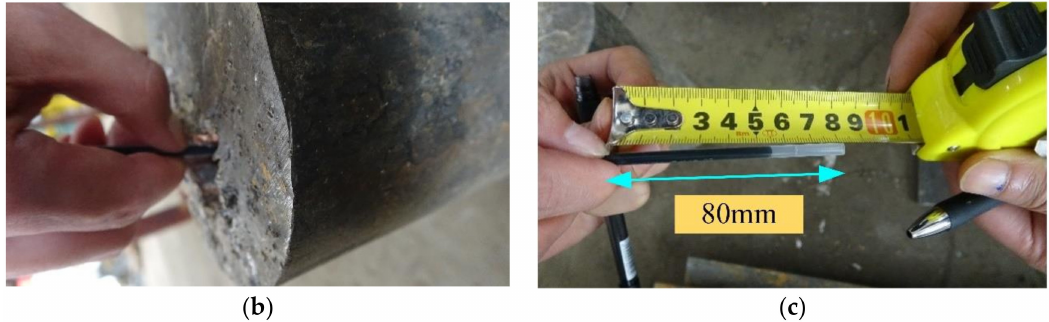
Figure 11. Ingot penetration results. ( a ) Measurement of the hole caused by the shaped energy jet; ( b ) measurement of the shaped energy jet’s penetration depth; and ( c ) depth of the shaped energy jet.